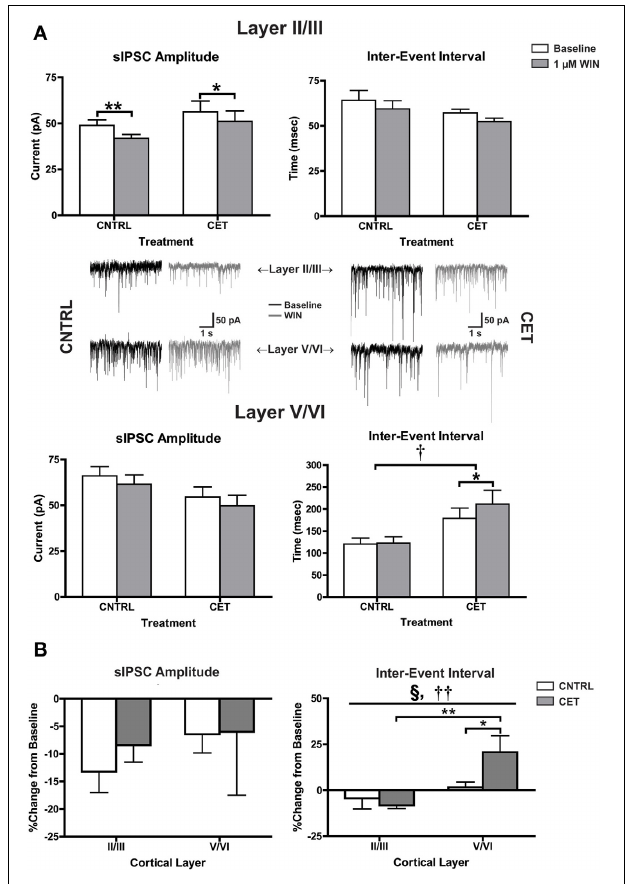
FIGURE 4 | CB1-mediated inhibition of GABAergic sIPSCs onto layer V/VI PNs is enhanced following CET. (A) The effect of WIN on spontaneous GABAA IPSCs recorded from layer II/III and layer V/VI PNs in control and CET cultures ( N = 7–12). White bars represent baseline measures and gray bars represent IPSCs recorded following a 10min application of WIN (1 μ M). Traces in the middle of (A) are representative examples from each of the four groups. The group of traces to the right is from control cultures, and traces to the left are from CET cultures. The top row of traces is from layer II/III PNs, and the bottom row is from layer V/VI. Black traces represent baseline recordings, and the adjacent gray traces are from the same neuron after a 10min WIN application. All data shown are mean ± s.e.m. Symbols: † , main effect of EtOH treatment; ∗ , significant pair-wise comparison. (B) the percent change of sIPSCs from layer II/III and layer V/VI neurons in control and CET cultures. All data shown are mean ± s.e.m. Symbols: §, interaction; † , main effect of cortical layer; ∗ , significant post-hoc comparisons. For all symbols conferring statistical significance: single symbol p < 0 . 05, double symbol p < 0 .